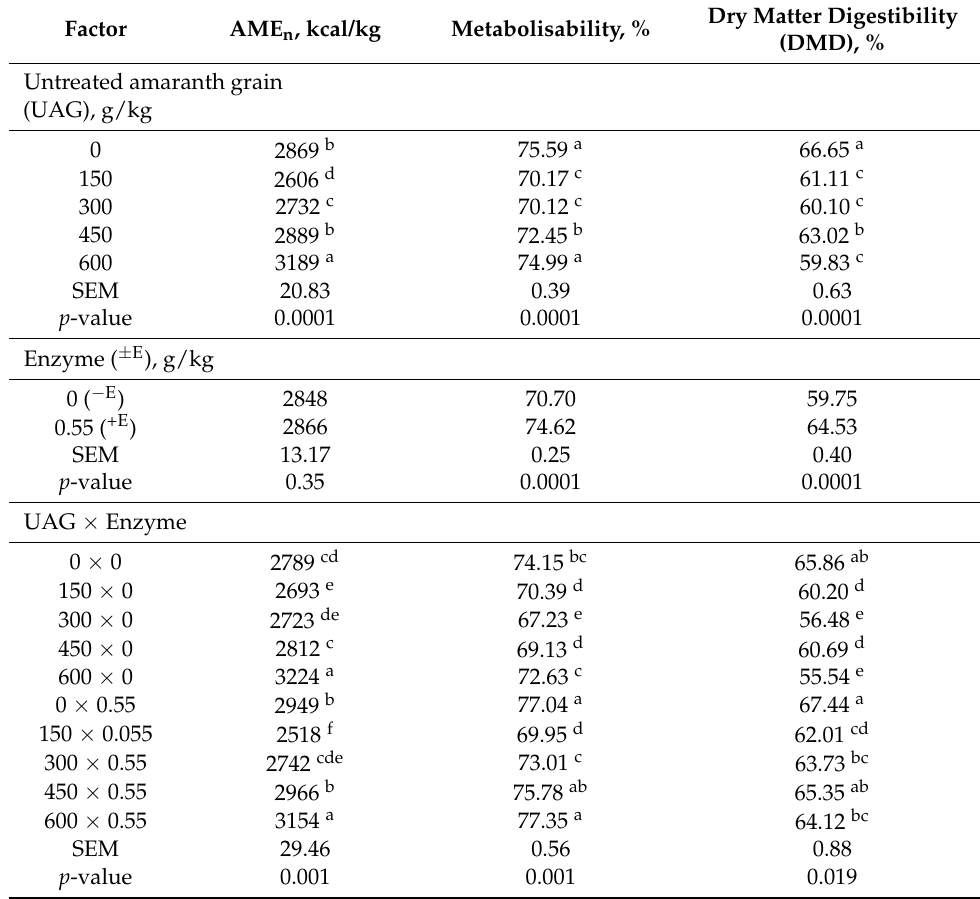
Table 3. AME n , metabolisability and dry matter digestibility (DMD) values of broiler chickens fed different levels of untreated amaranth grain (UAG) with ( +E ) and without ( − E ) enzyme from 35 to 42 d of age in the second